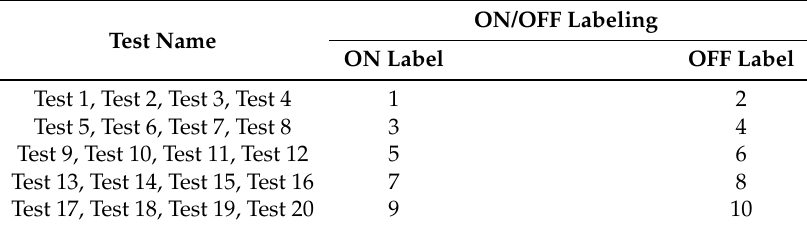
Table 6. Labeling ON/OFF for twenty test